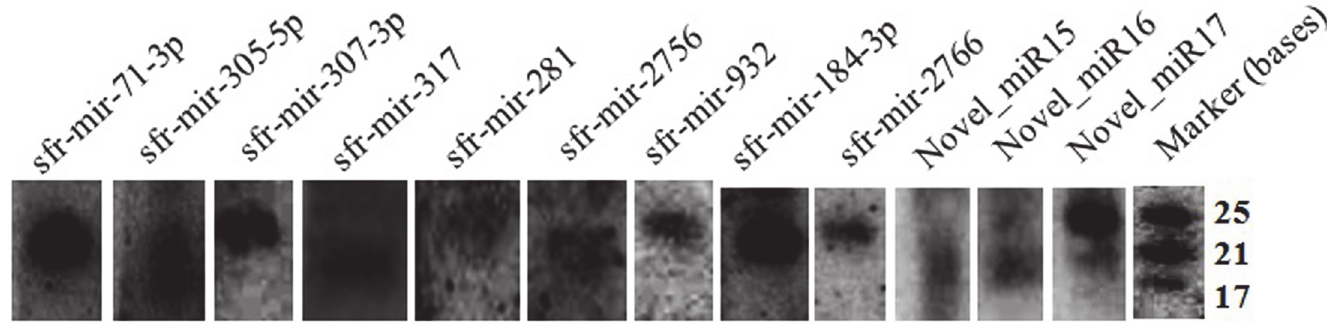
Fig 4. Northern validation of selected miRNAs. Both the known and novel miRNAs were checked by northern analysis for their expression in Sf21 cells using the total RNA isolated from them. All the miRNAs exhibited the expected sizes from the library.